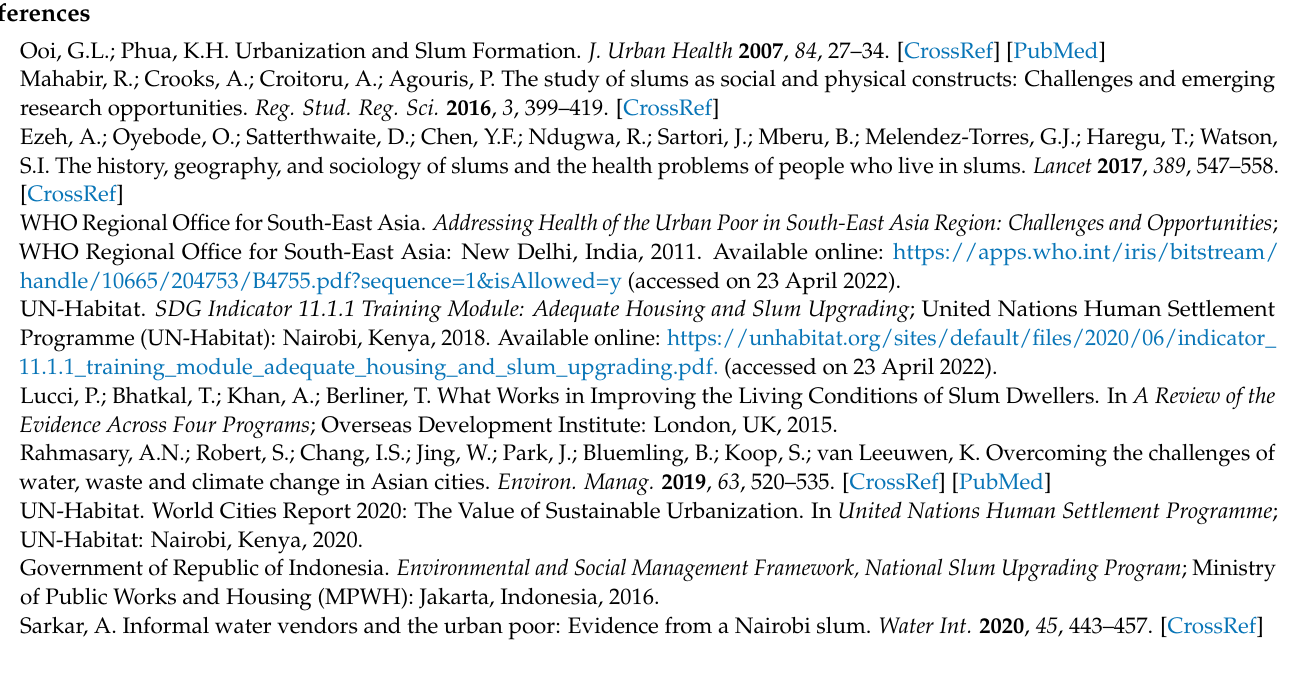
Figure A1. Samples of water sources available in study area: ( a ) communal borehole, ( b ) protected dug well, and ( c ) KOTAKU borehole. Table A1. Water tariff of different water sources in the study area.